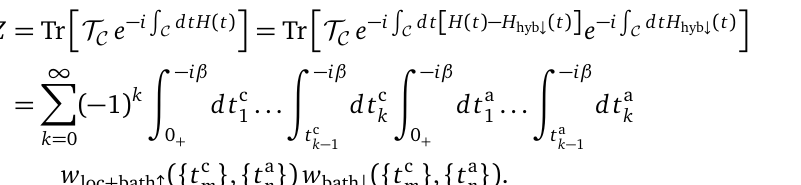
Figure 1: Graphical representation of CT-HYB and CT-1 / 2-HYB expansions on the Keldysh contour . The contour starts at 0 + at the upper real branch, goes to t C then goes back to 0 − along the lower real branch and eventually reaches − i β along the imaginary axis. Full and empty circles denote virtual creation and annihilation processes of impurity electrons. Bold blue line denotes the semi-analytic dressing of spin-down expansion diagrams by all the spin-up